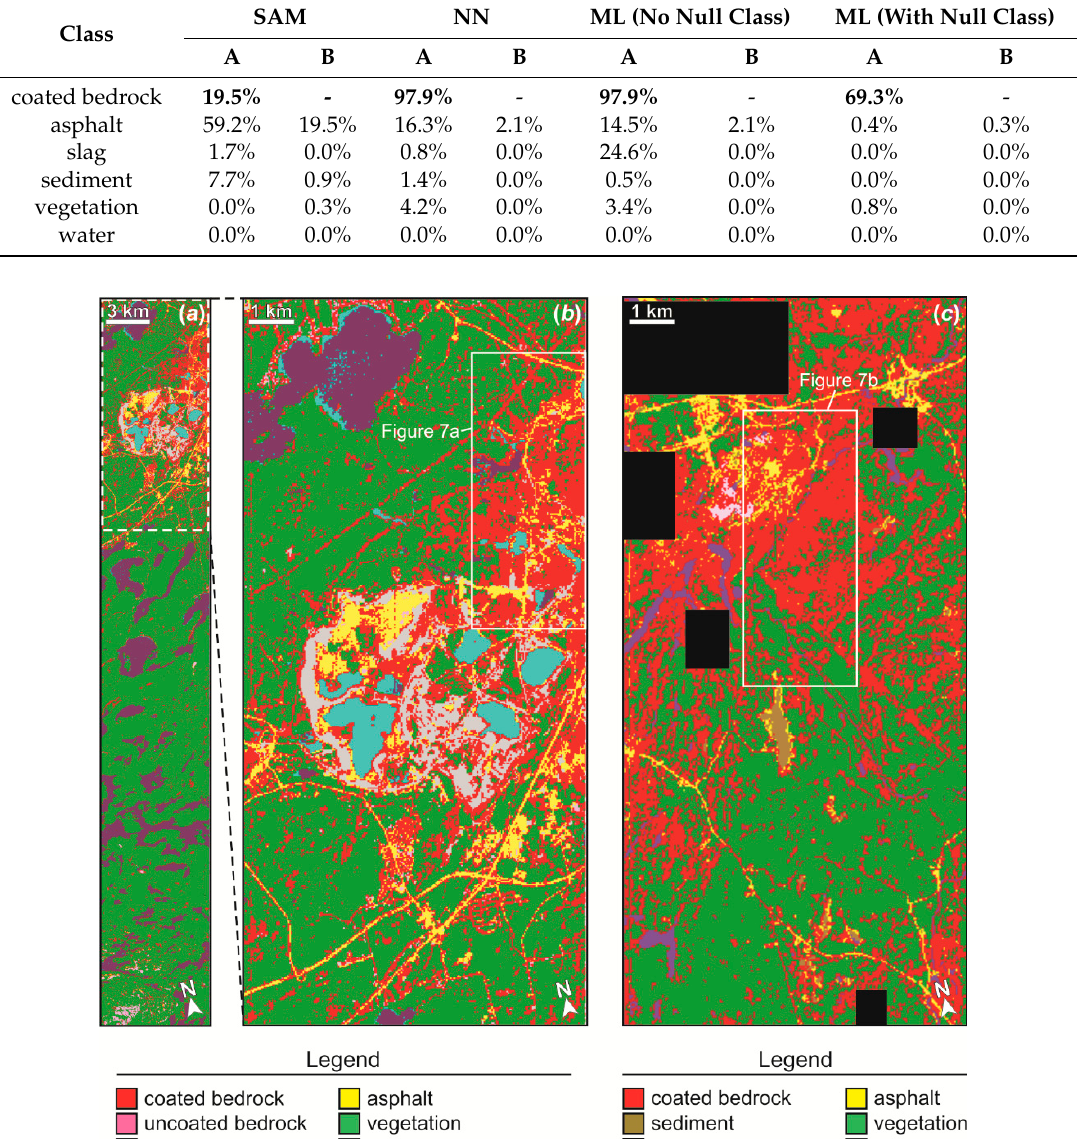
Table 2. Spectral angle mapper (SAM), neural network (NN), and maximum likelihood (ML) results for the Coniston study area (Figures 9–12). A: proportion of test pixels correctly classified (bold) or misclassified as coated bedrock (errors of commission). B: proportion of coated bedrock test pixels misclassified as uncoated classes (errors of omission).